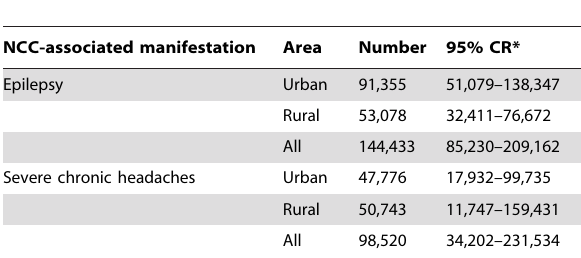
Table 3. Estimated numbers of people with NCC-associated epilepsy and severe chronic headaches in Mexico.